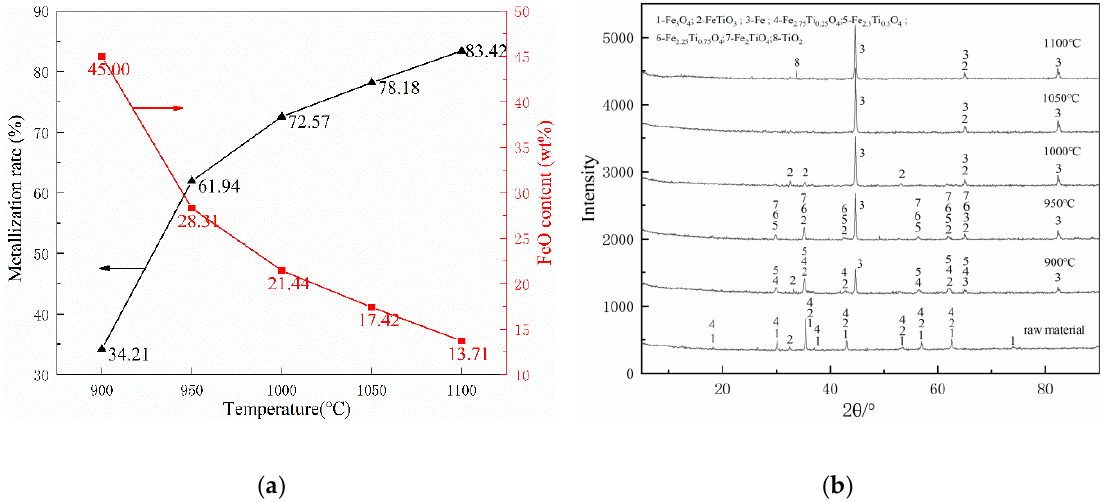
Figure 5. Effects of various reduction temperatures on composite’s behaviors: ( a ) metallization ratio and FeO content and ( b ) phase change.